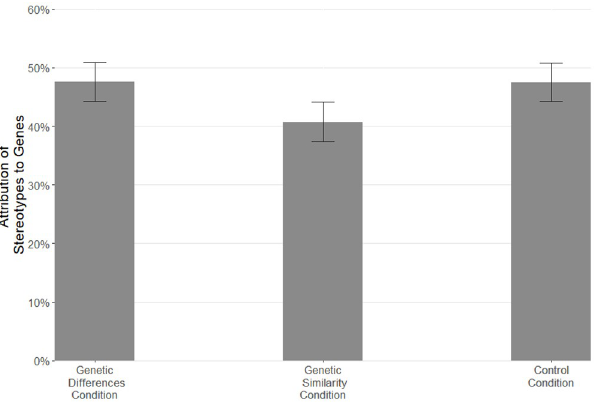
Fig 1. Mean attribution of stereotypes to genes by condition. Error bars are 95% confidence intervals.